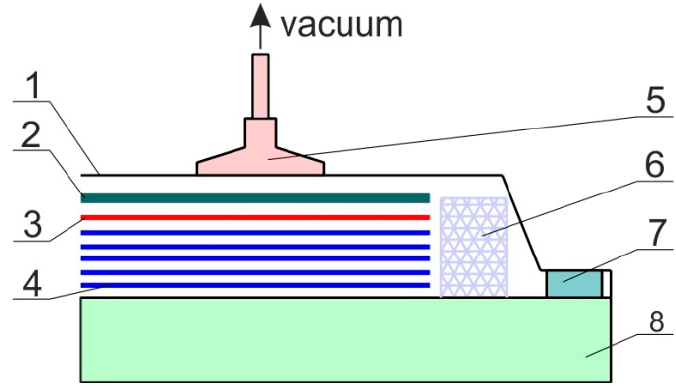
Figure 27. Schematic diagram of the autoclave setup: 1—vacuum bag, 2—breather cloth, 3—release film, 4—prepreg plies, 5—valve, 6—edge bleeder, 7—sealant, 8—tool. Bars and profiles can be produced by the pultrusion method. Fibre is pulled through